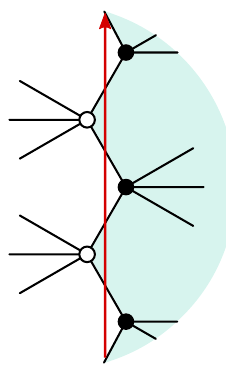
Figure 2. A ZZP as an anomaly